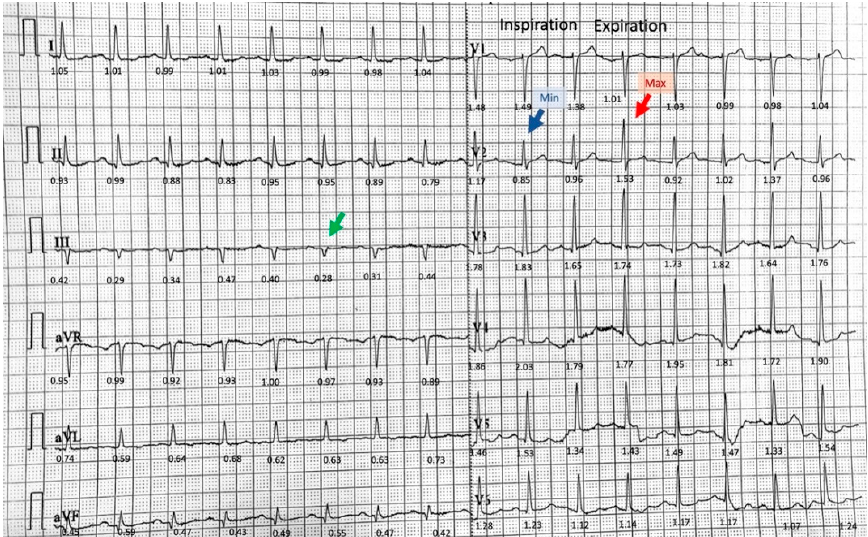
Figure 1. The electrocardiogram on admission. Voltage expressed in millivolts is displayed under each QRS complex. Phasic variations of the QRS amplitude seen in lead V2 with the minimum voltage (blue arrow) during inspiration and maximum voltage (red arrow) during expiration. Isolated low QRS voltage is seen in lead III (green arrow).